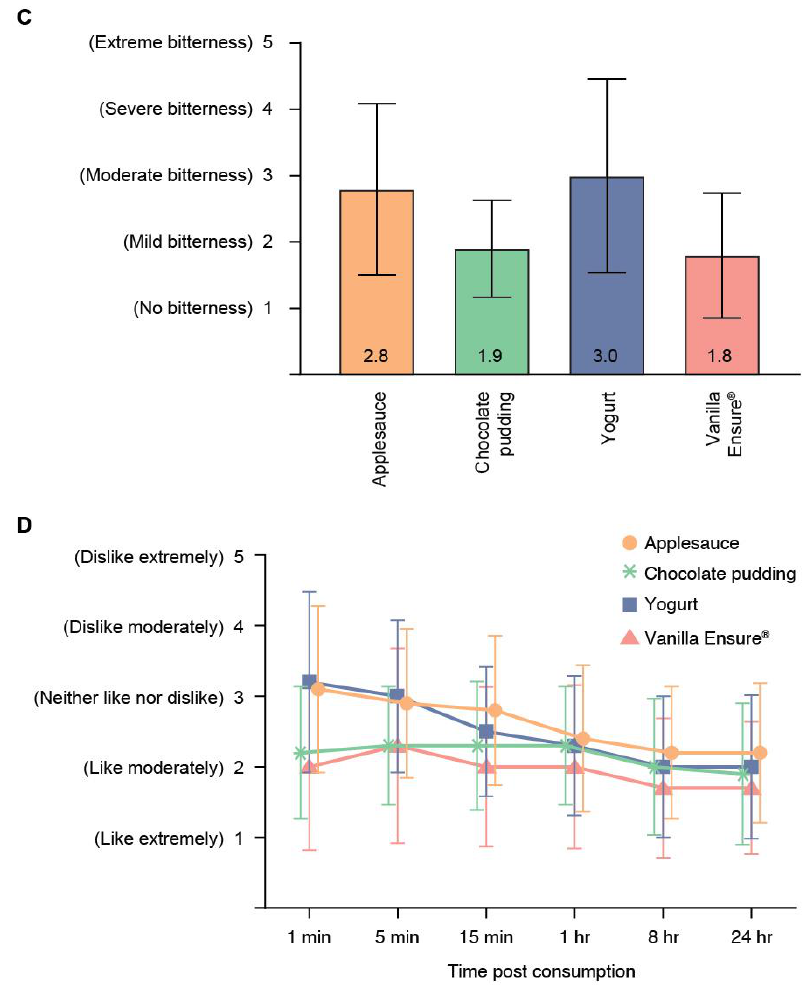
Figure 3. Secondary endpoint assessments of ( A ) mouthfeel, ( B ) smell, ( C ) bitterness, and ( D ) aftertaste of pimavanserin/food vehicle mixtures. Data shown are the mean (SD) of participant assessments ( n = 18) of pimavanserin 34 mg mixed with 15 mL of indicated food vehicle. SD = standard deviation.